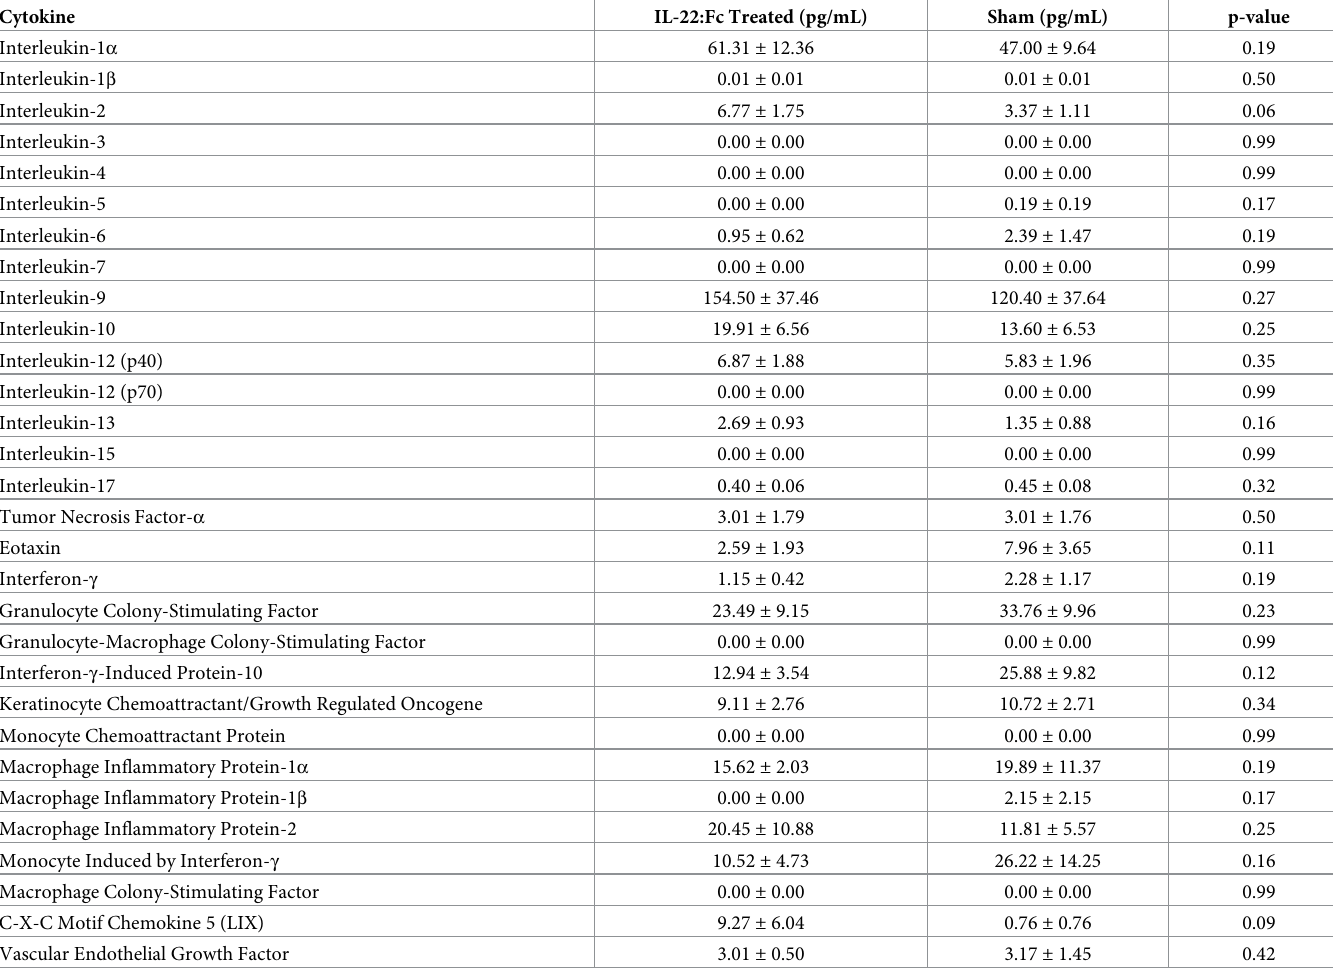
Table 2. A comparison of IL-22:Fc treated and sham animals after acute lung injury with low dose